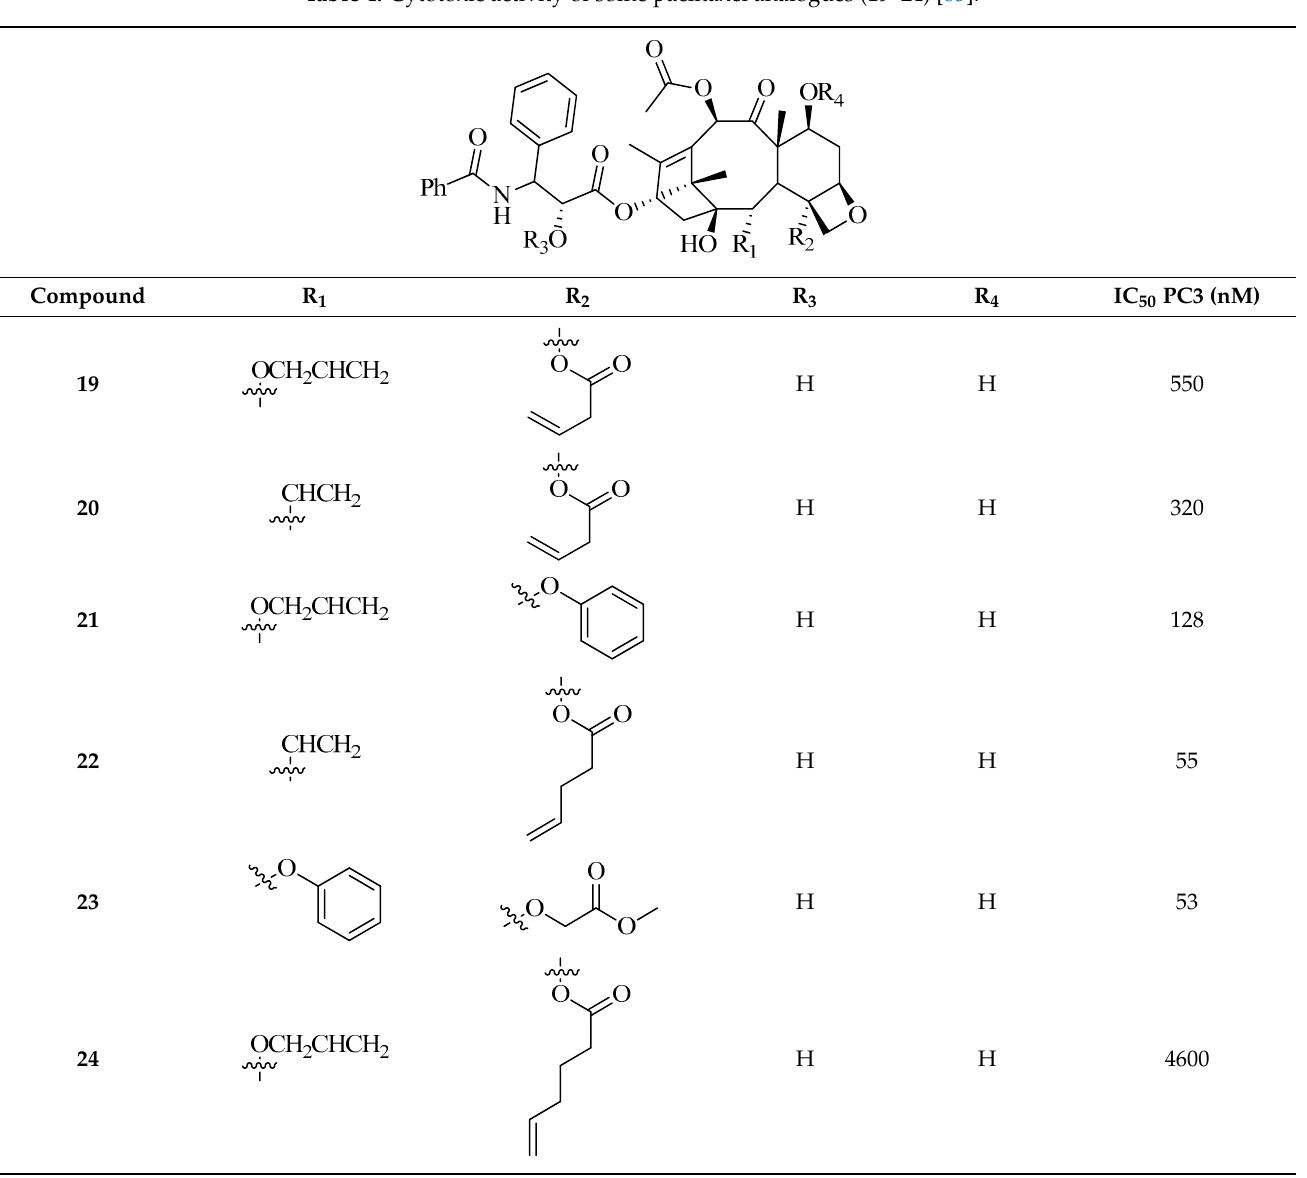
Table 4. Cytotoxic activity of some paclitaxel analogues ( 19 – 24 ) [85].